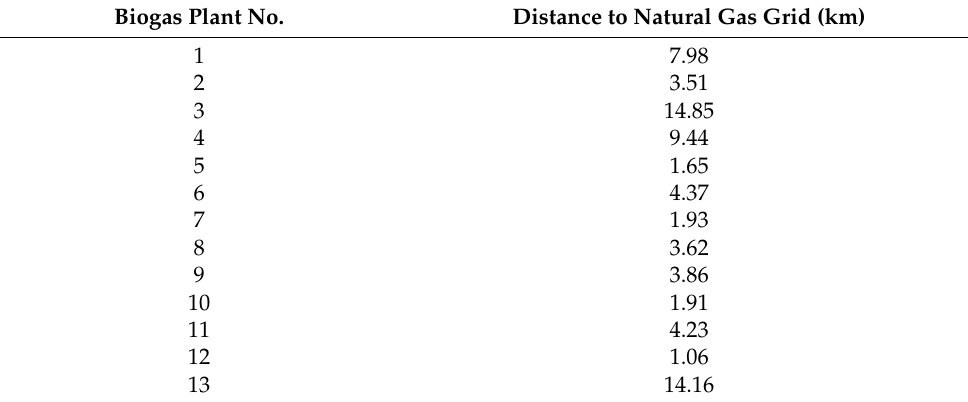
Table 5. Distances between examined biogas plants and the natural gas grid. Biogas Plant No.